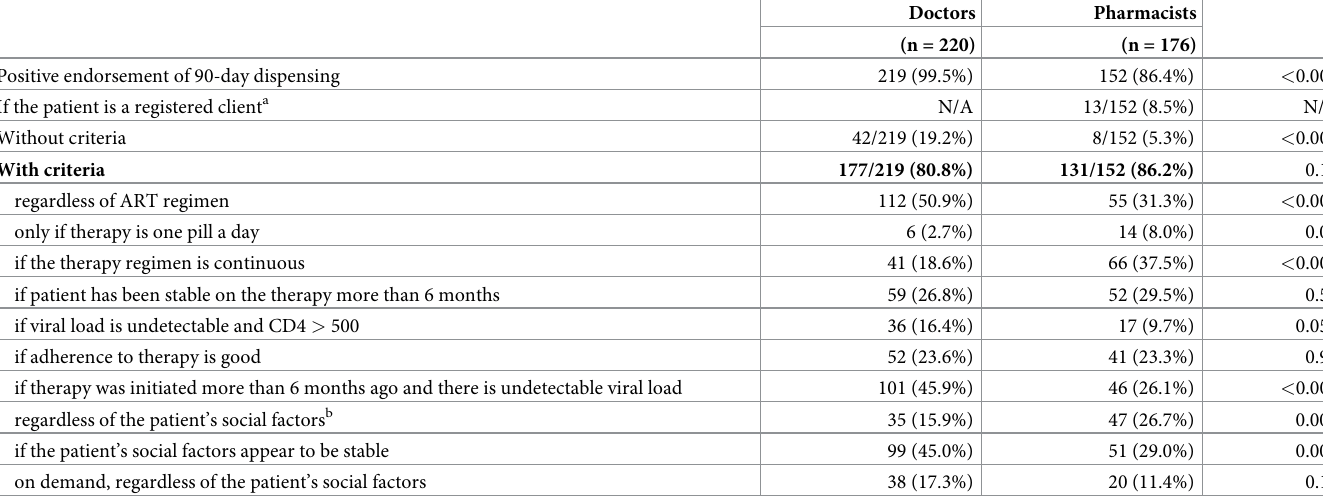
Table 5. Comparative analysis of responses from doctors and pharmacists concerning eligibility therapeutic, immunovirologic, or social conditions for 90-day ART dispensing.